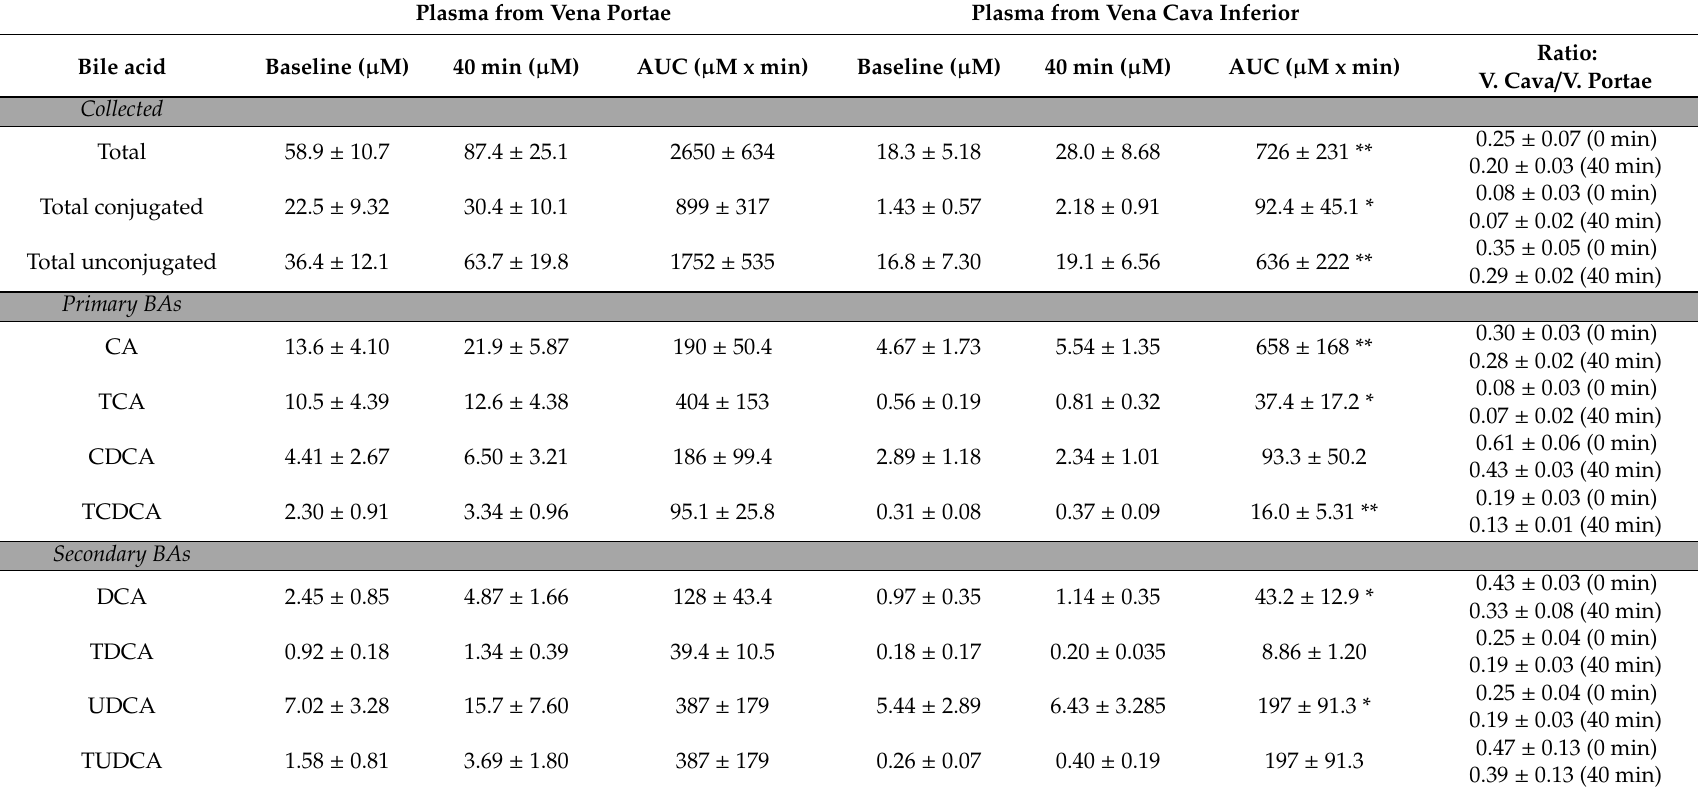
Table 1. Bile acids in plasma from vena portae and vena cava